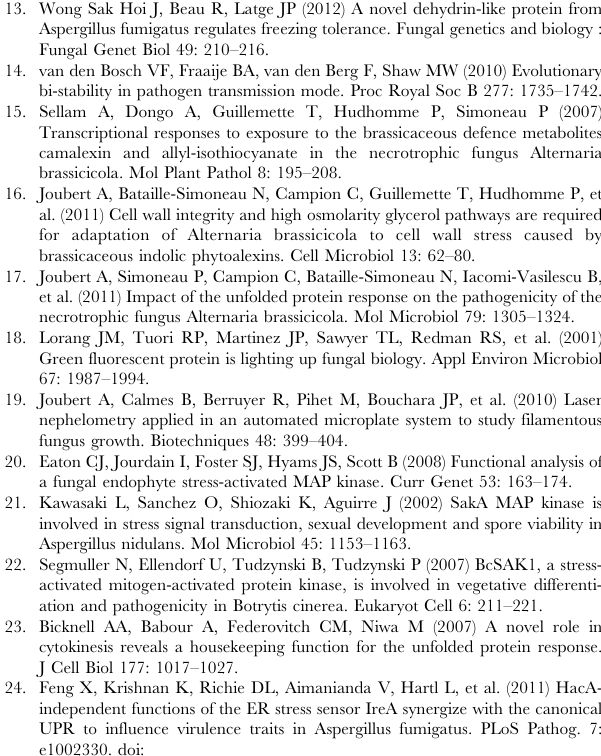
Figure S5 Schematic representation of the construction of AbDhn-Gfp fusion cassette. Targeted ORF and 3 9 flanking region were amplified from A. brassicicola wild-type genomic DNA with two sets of primers (P1/P2 and P3/P4). Reverse primer P2 was designed so that the original stop codon was replaced by three Glycin codons. The sGfp coding sequence (stripped boxes) and Hph gene cassette were amplified from pCT74 [18] and pCB1636 [41], respectively. The four PCR fragments were fused using the double-joint PCR procedure described by Yu et al [40]. The resulting DNA fragment was introduced into A. brassicicola by protoplasts transformation and double crossing–over events replaced the wild locus by the AbDhn-sGfp-Hph cassette. Table S1 lists the different primers that were used for each AdDhn gene: Table S1 List of primers used in this